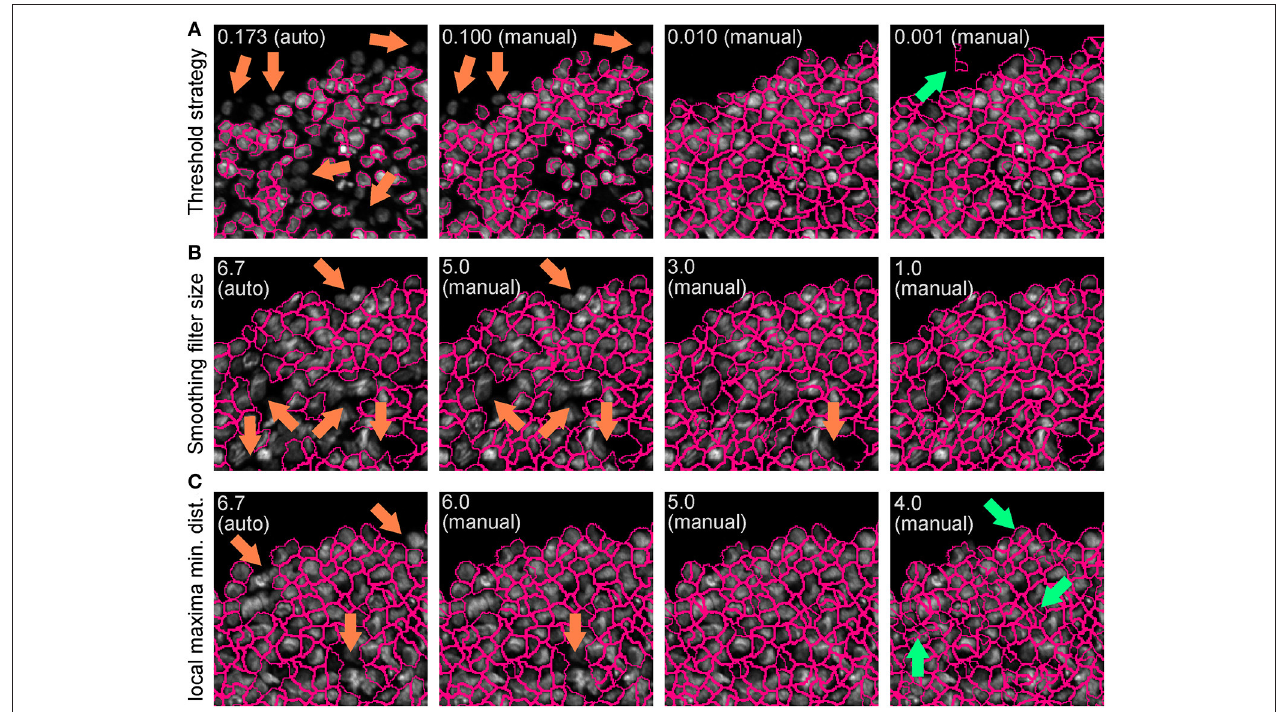
FIGURE 5 | Effect of “IdentifyPrimaryObjects” parameters on object identification accuracy. Spheroid nuclei identification results from automatically (auto) and manually (manual) set threshold strategy (A) , size of smoothing filter for declumping (B) and minimum allowed distance between local maxima (C) . Magenta outlines indicate identified objects. Orange and green arrows indicate false negative and false object identification,